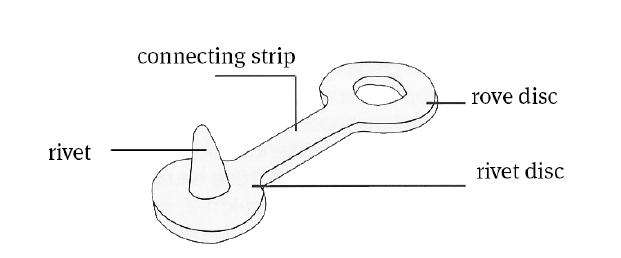
Figure 3. Seal components (Egan, 1987, fig. 2A).